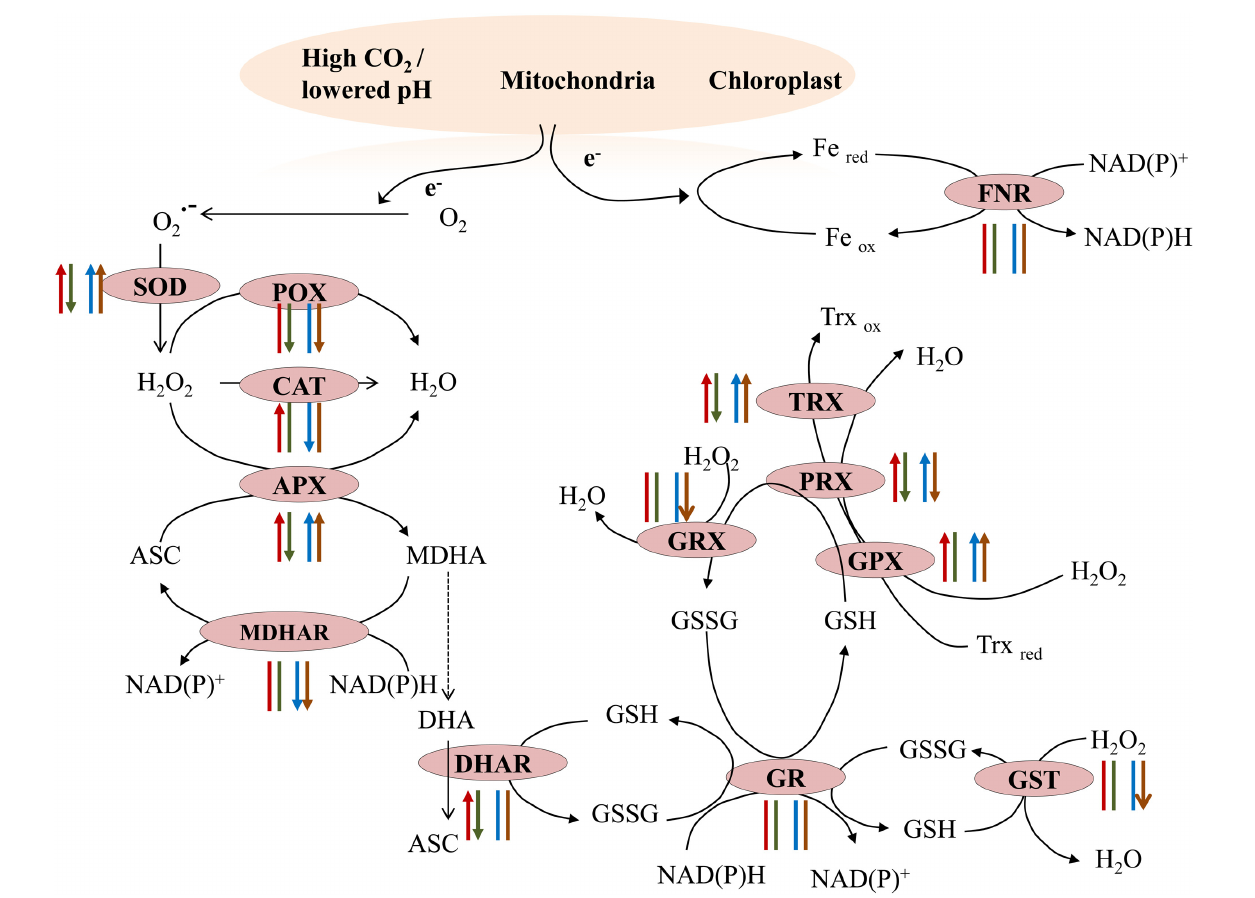
FIGURE 5 | Summary of antioxidant enzymes activity in natural populations and in transplants. Transplants: control to acidified (red arrow), acidified to control (green arrow); natural populations: March (blue arrow), July (brown arrow). Arrow head up: increased activity; arrow head down: decreased activity; arrow without head: no changes in the activity.